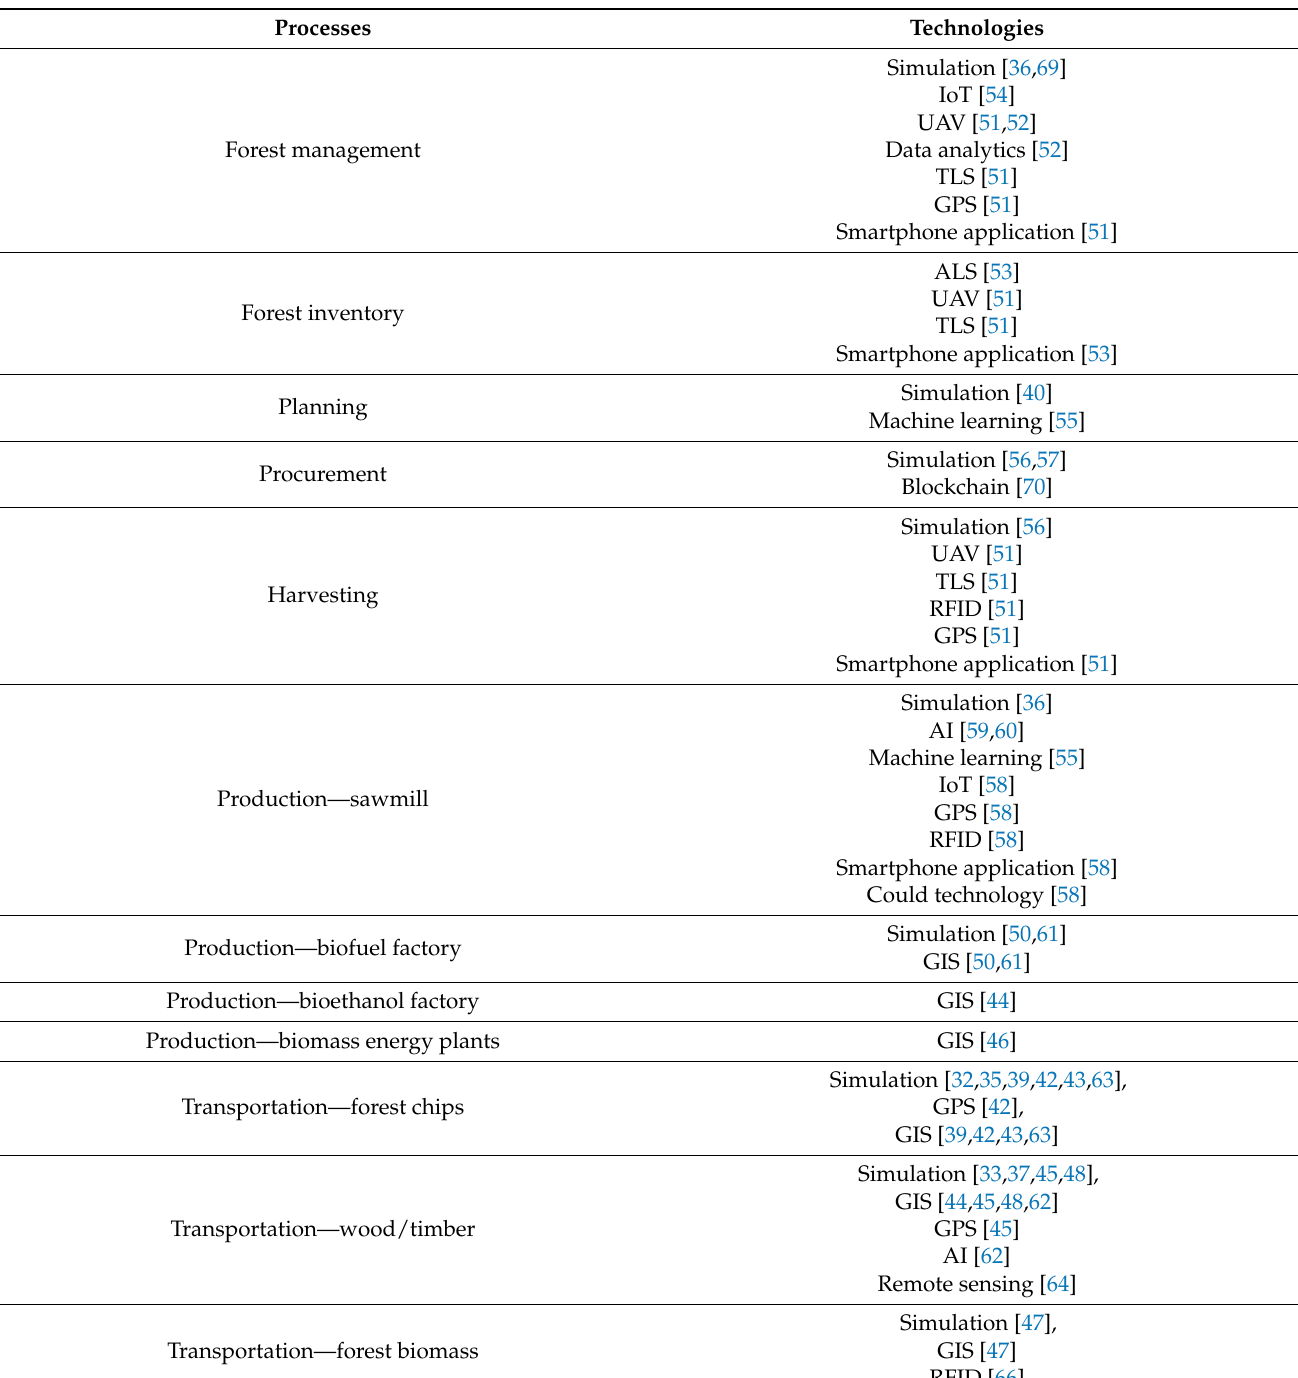
Table 3. Technologies used in the different processes of the forest supply